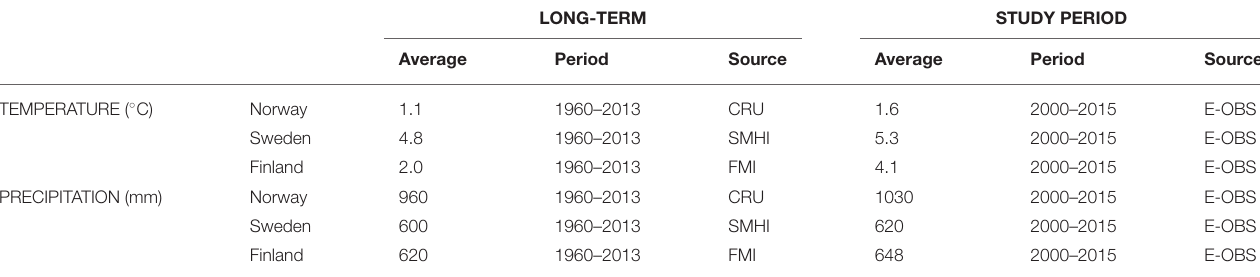
TABLE 3 | Long-term and study-period annual average temperature, precipitation, and length of the growing season.